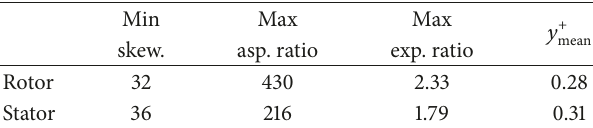
Table 3: Mesh quality